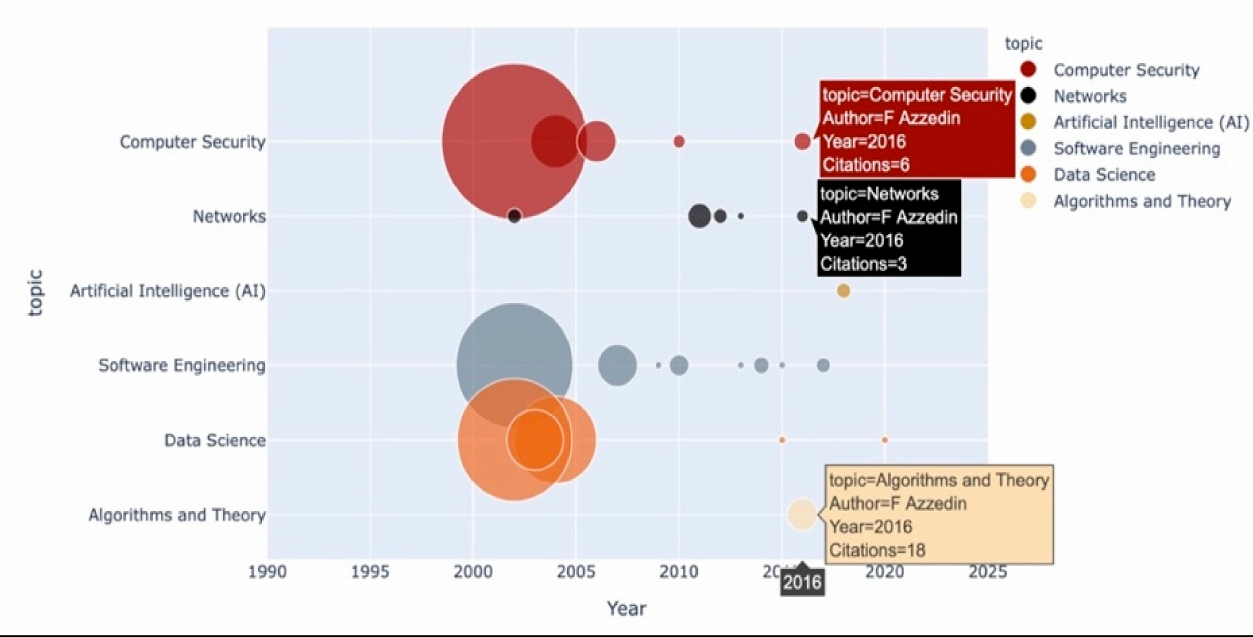
Figure 18. Topics distribution of publications over the